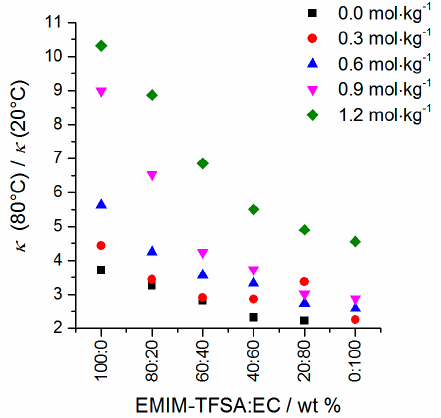
Figure 10. Temperature dependency of the conductivity data of the mixtures at selected EMIM-TFSA/ EC mass fractions.